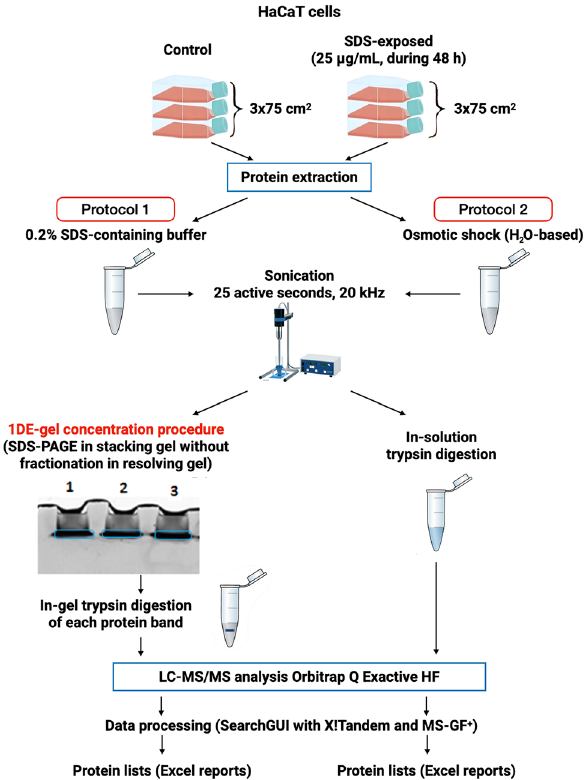
Figure 1. The experimental design used in the proteomic study of HaCaT keratinocytes. After growing to ~ 60–70% confluence, the cultured cells were divided into two groups, one was control (fresh medium was added), and another was exposed to SDS in the non-toxic dose (25 μg/mL) during 48 h. Protocol 1—HaCaT cells were solubilized in 0.2% SDS-based solution and sonicated. The obtained protein extracts were deposited onto polyacrylamide stacking gel (4%T, in triplicate, 50 μg of protein per gel run). Electrophoresis (50 V, 20 min) was terminated before the migration of Bromophenol blue in the resolving gel. The single protein band was excised from gel holistically and digested with trypsin. Protocol 2—HaCaT cells were mixed with cold deionized water and sonicated. Then, the in-solution trypsin digestion was performed. In both protocols, the resulting mixture of peptides was extracted for LC-MS/MS analysis. The spectra were processed with the SearchGUI platform utilizing X!Tandem and MS-GF + search algorithms. Processing parameters are given in the Methods